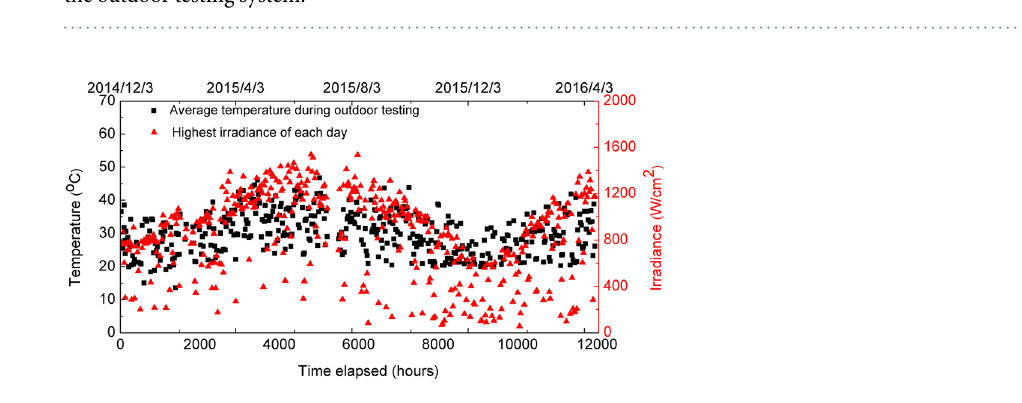
Figure 3. Evolution of the device metrics as a function of time (normalised to initial values) determined using the outdoor testing system.